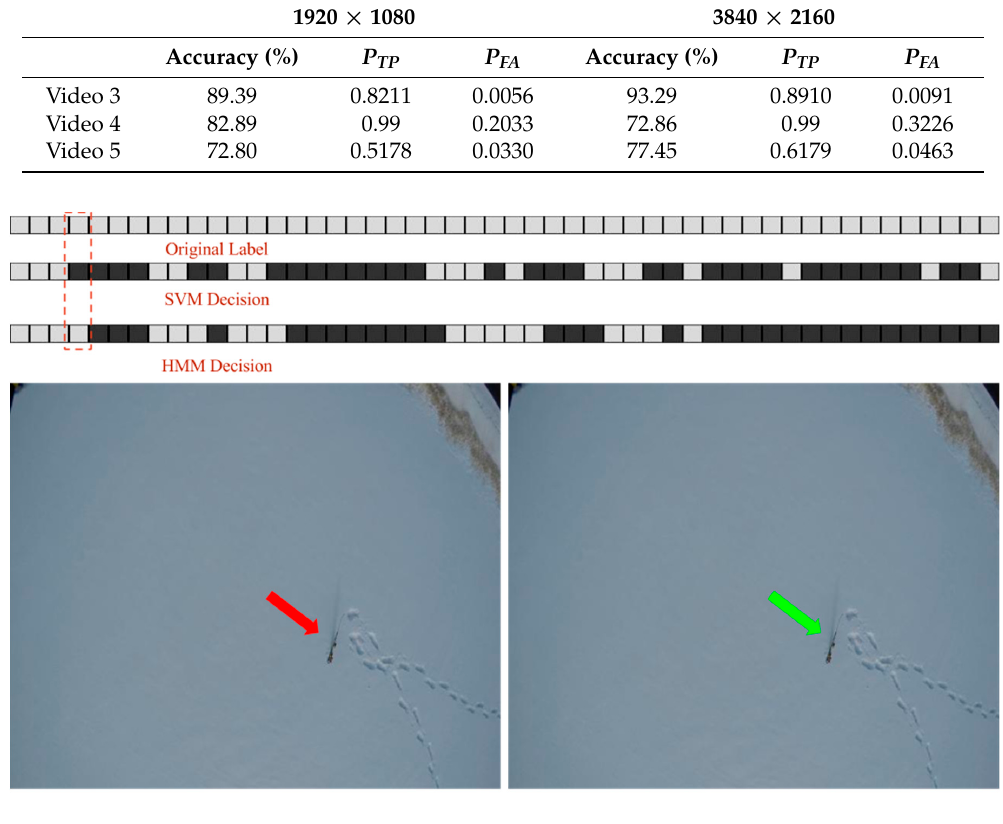
Figure 11. Example of positive change by HMM. The sequence of white and black squares on top indicates the label of successive frames. A white square indicates a frame has object of interest whereas a black square indicates the opposite. The frame where the change happened is outlined by a red dotted rectangle and the corresponding frame in the bottom. The frame for which SVM made a wrong decision is shown in the bottom left (the object in the frame, skis in this case, is indicated by a red arrow), whereas the same frame corrected by HMM is shown in the bottom right (the object in the frame is indicated by a green arrow). Note that the object is not localized since a post-processing decision is made at the frame level.